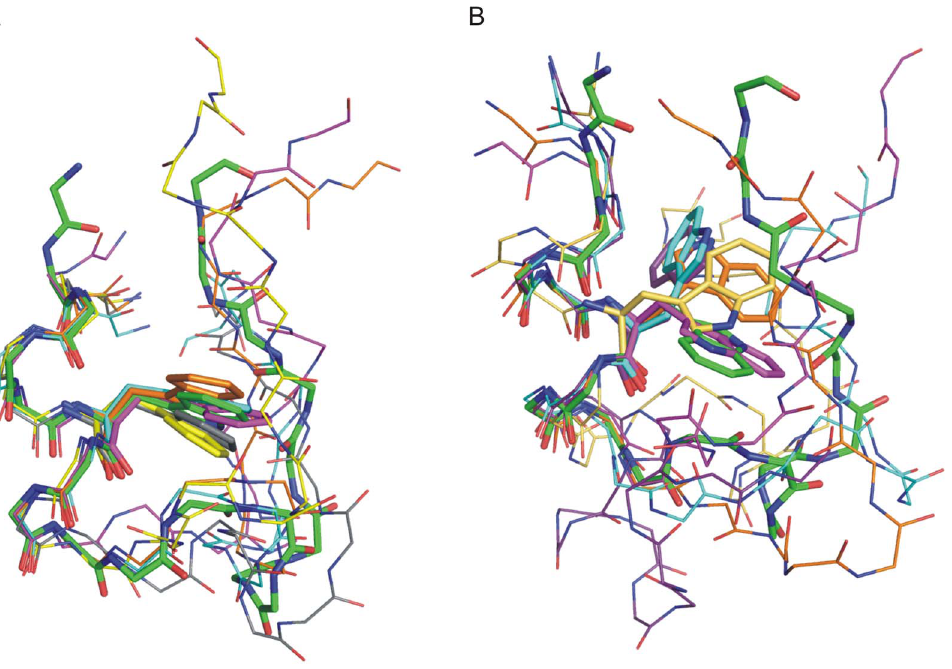
Figure 4. Structural superposition of Set1 and Set2 intermediate start structures. Superposition of (A) set 1 and (B) set2 intermediate start structures (superimposed on a -helix of the native Trp-cage structure indicated as atom colored stick representation). The intermediate start structures are shown as thin sticks using different colors. For clarity only the side chain of the central Trp6 residue in each structure is shown explicitly (stick